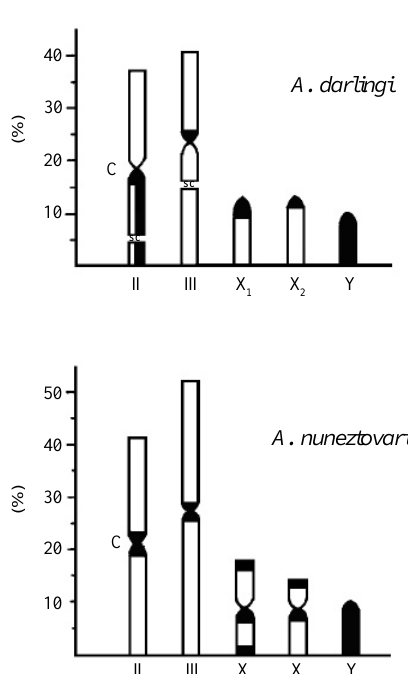
Figure 1 - Diagrammatic comparison of metaphase karyotypes of Anophe- les darlingi and Anopheles nuneztovari from Manaus and Macapá. Only one set of autosomes (II and III) is shown. Variable heterochromatic por- tions are indicated in black. Chromosomes and heterochromatic portions are shown as a percentage of the total length. c = Centromeric region; sc = secondary constriction.